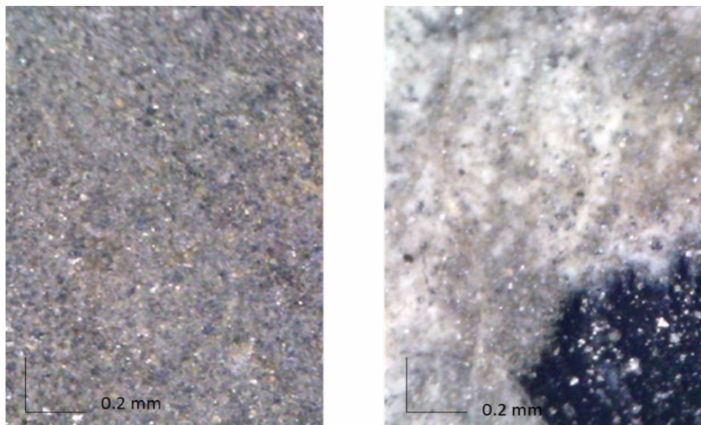
Figure 3. ( left ) OM (200 × ) of the front of the painting: small metallic grains and blue pigment grain are visible; ( right ) OM (200 × ) of the restored area on the front of the painting: the different aspect of the silver area is evident, together with the green